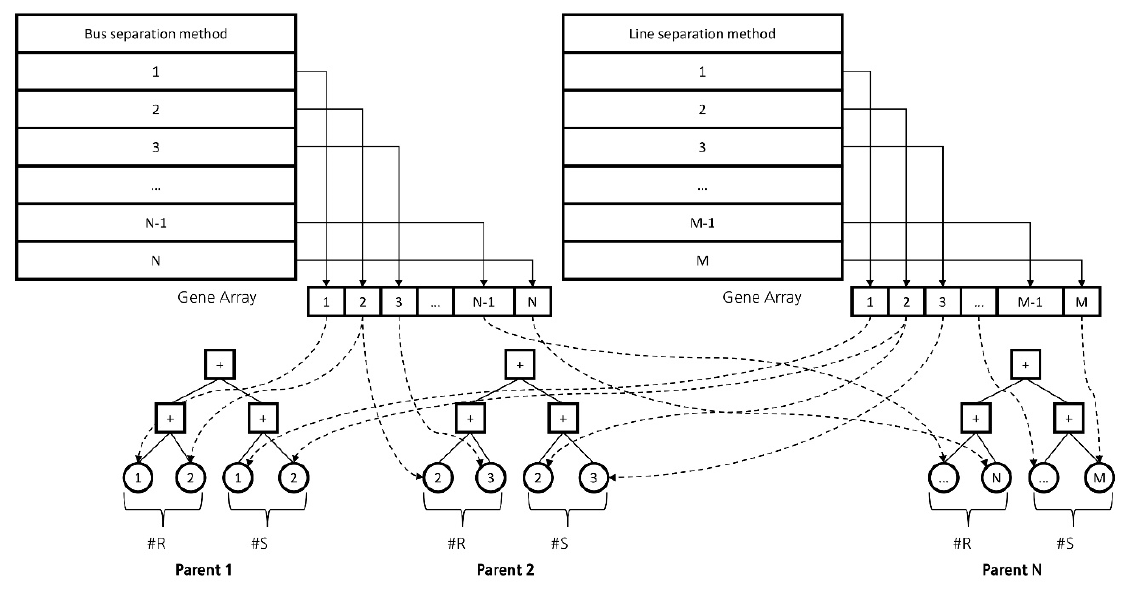
Figure 6. Gene array configuration plan with the bus and line separation methods in GP.